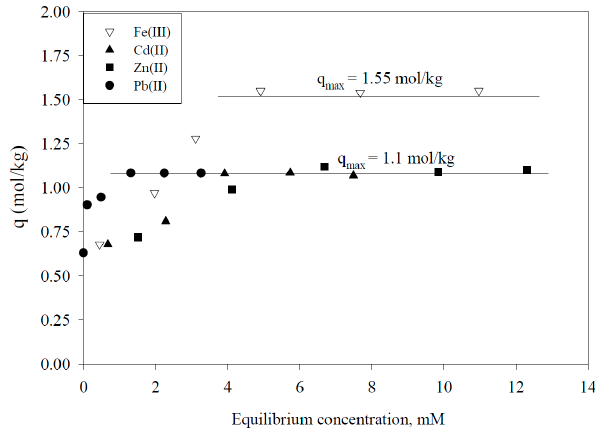
Figure 19. Isotherms for the adsorption of some metal ions by SOJR gel at pH ca. 2 [13]. (With permission for reuse from Elsevier B.V.).